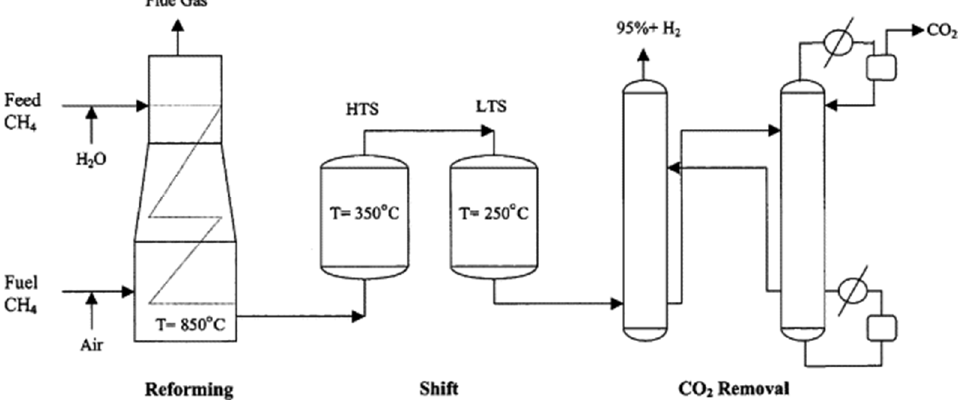
Figure 2. The general process of steam methane reforming [9].